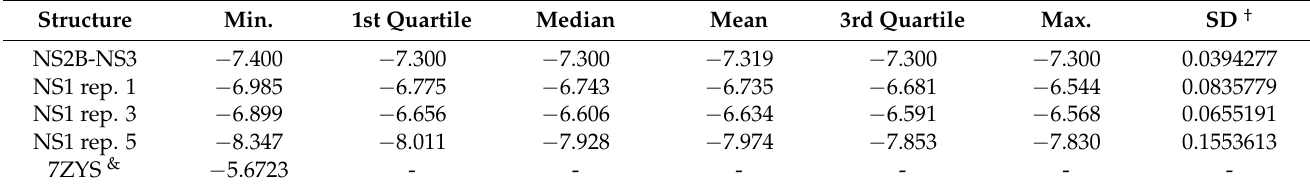
Table 1. AutoDock Vina (ADV) docking results in kcal/mol.